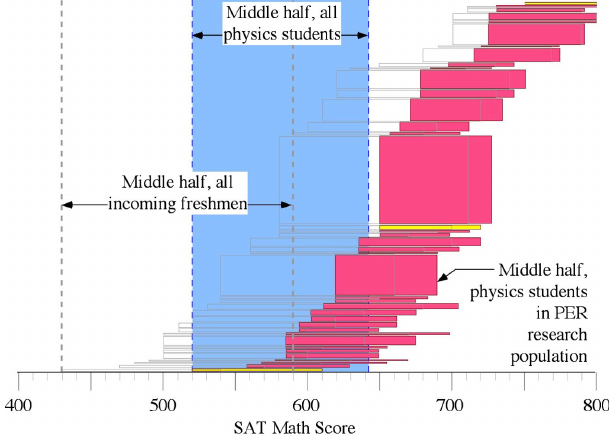
FIG. 7. Our best guess about the overlap between research population and overall physics student population. Based on our knowledge of how SAT Math scores change from incoming freshmen to students in calculus-based physics courses for 2 institutions (shown in yellow), and on the assumption that the scores do not change for the school with the highest scores (also in yellow), the 25th – 75th percentile ranges shown in Fig. 3 have been mapped to predicted ranges for students in calculus-based physics courses. Score mapping is done by quadratic fit. The data for incoming freshmen from Fig. 3 is shown outlined in light gray for comparison, as are the limits for the middle half